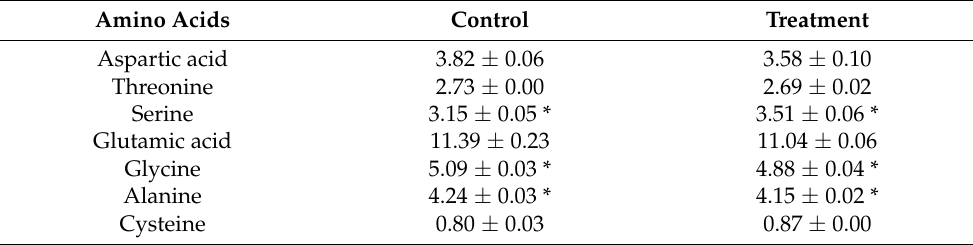
Table 5. Comparison of the whole-body amino acid profile in A. schrenckii